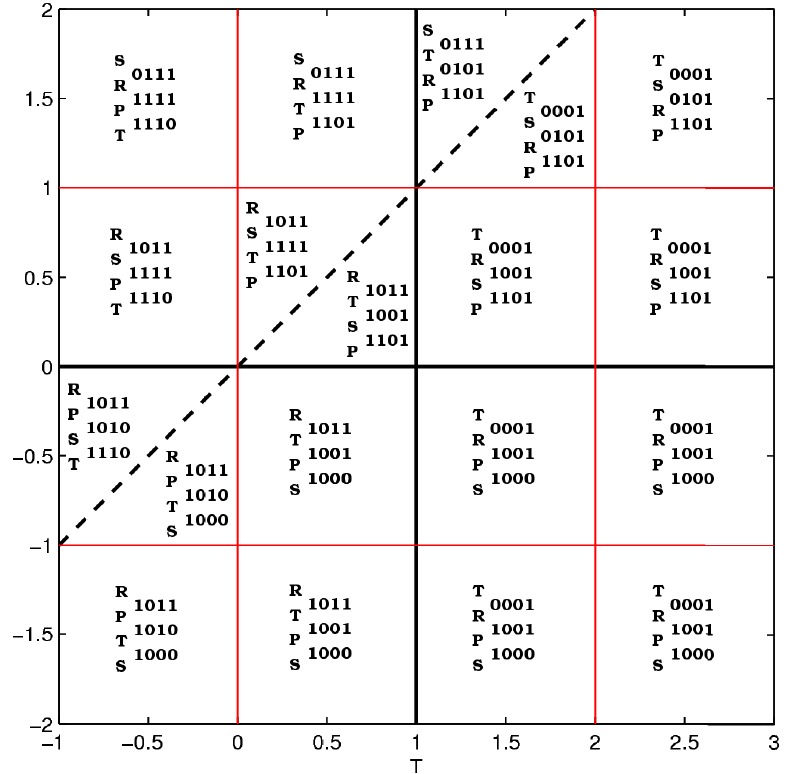
Figure 2. Distribution of the payoffs and the different win-stay, lose-shift strategies. Strategies are ordered according to decreasing aspiration level [32] in the different regions of the ( S , T ) plane.